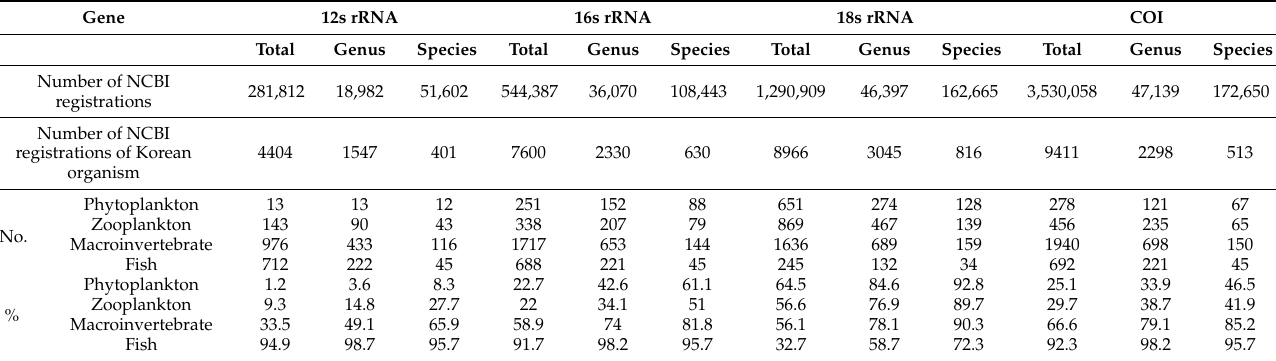
Table A1. Comparison of number of registered gens on NCBI with Korean species